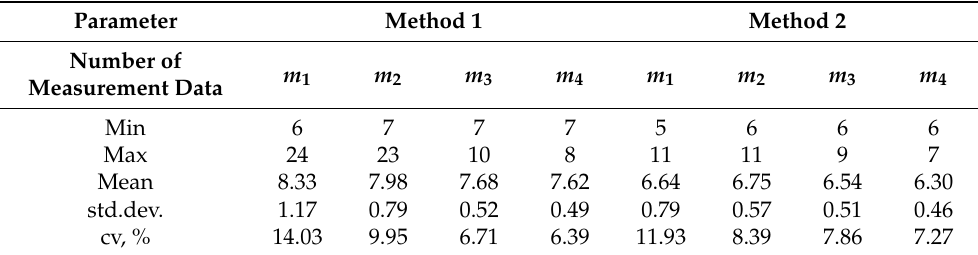
Table 2. Number of iterations in the state estimation for load level V 1.5 .